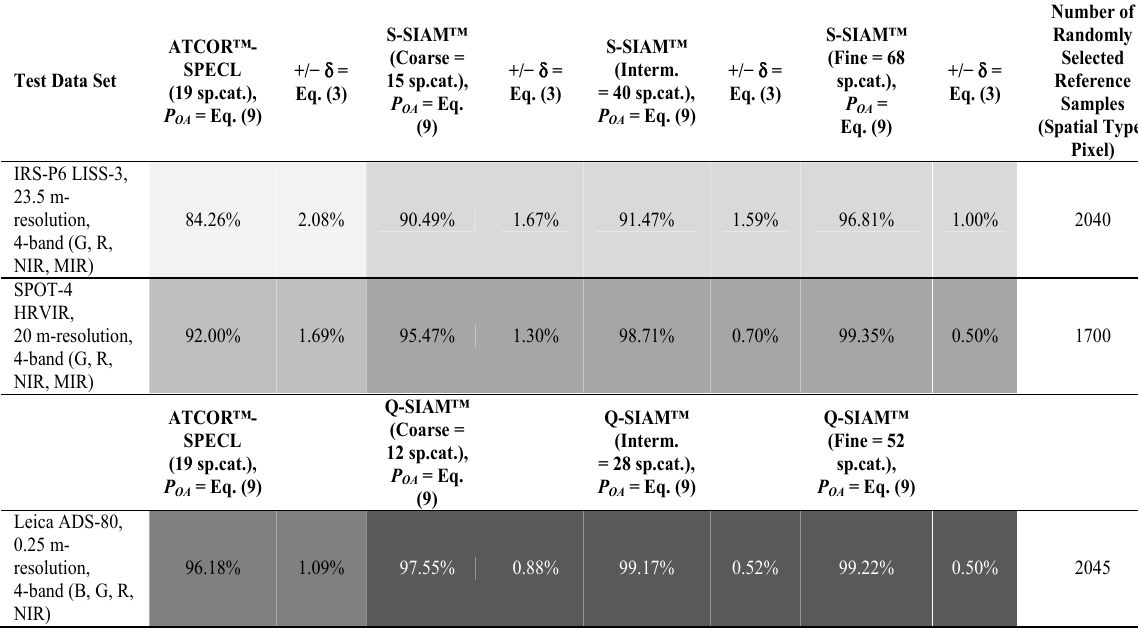
= Equation (9) ±δ = Equation (3) for the Table 15. Overall Accuracy (OA) = (cid:1868) (cid:3016)(cid:3002) ATCOR™-SPECL and SIAM™ pre-classifications of the three test images, with α = 0.05, 1 − α = 0.95, χ 2 = 3.84 in Equation